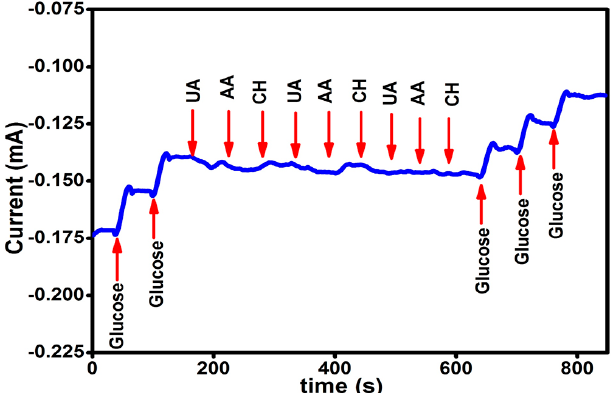
Figure 6. Amperometric responses obtained at successive addition of glucose and each of UA, AA, and CH in 0.1 M NaOH solution at +0.13 V (vs. Ag/AgCl) with regular intervals of 50 s.